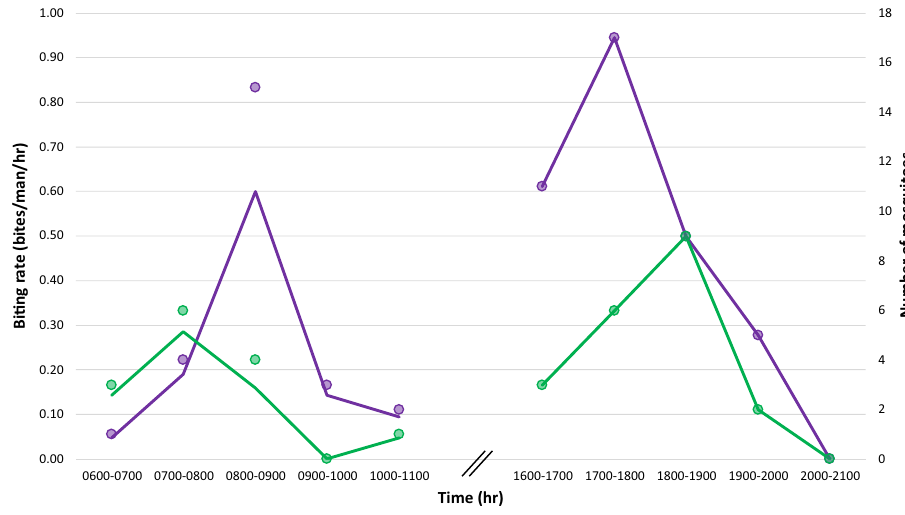
Figure 4. Biting behaviour (line) and the number (circle) of An. collessi (purple) and An. roperi (green) collected from site SM between 0600–1100 h and 1600–2100 h. Two circles overlap between 1800 and 1900